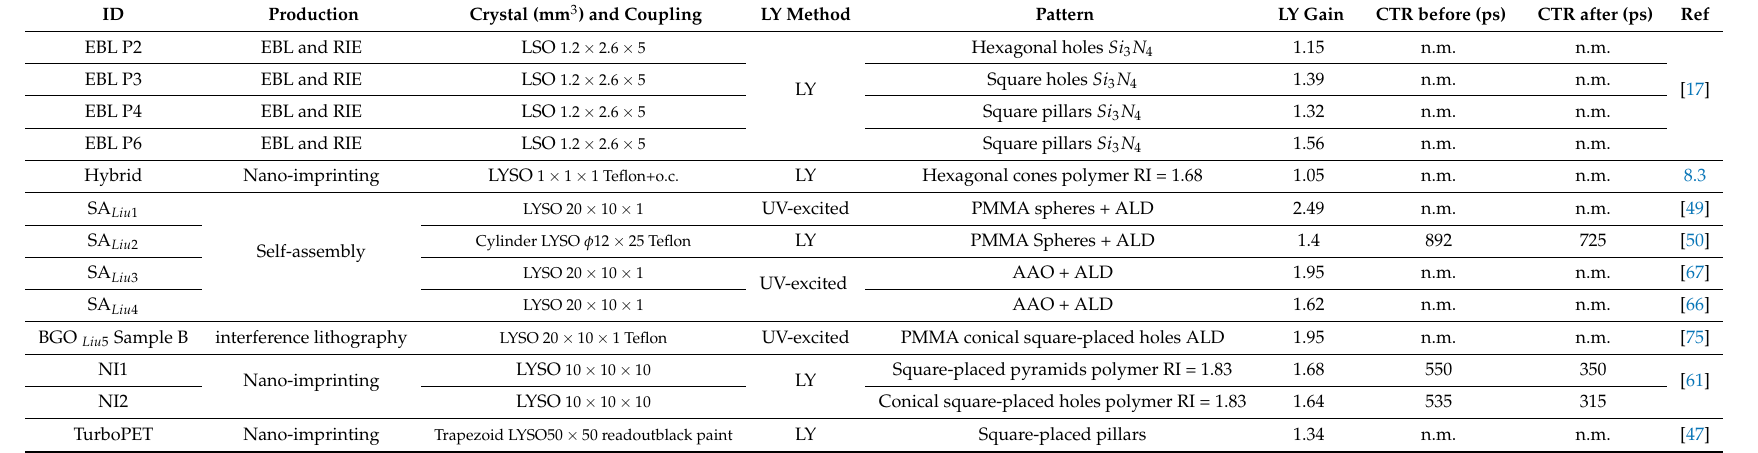
Table 1. Experimental results obtained by the various groups active in applying PhC slabs to inorganic scintillators. n.m. stands for not measured; o.c. stands for optically coupled; EBL stands for electron beam lithography; RIE stands for reactive ion etching. The first two numbers of the crystals’ dimensions always represent the readout face. LY, light yield; ALD, atomic layer